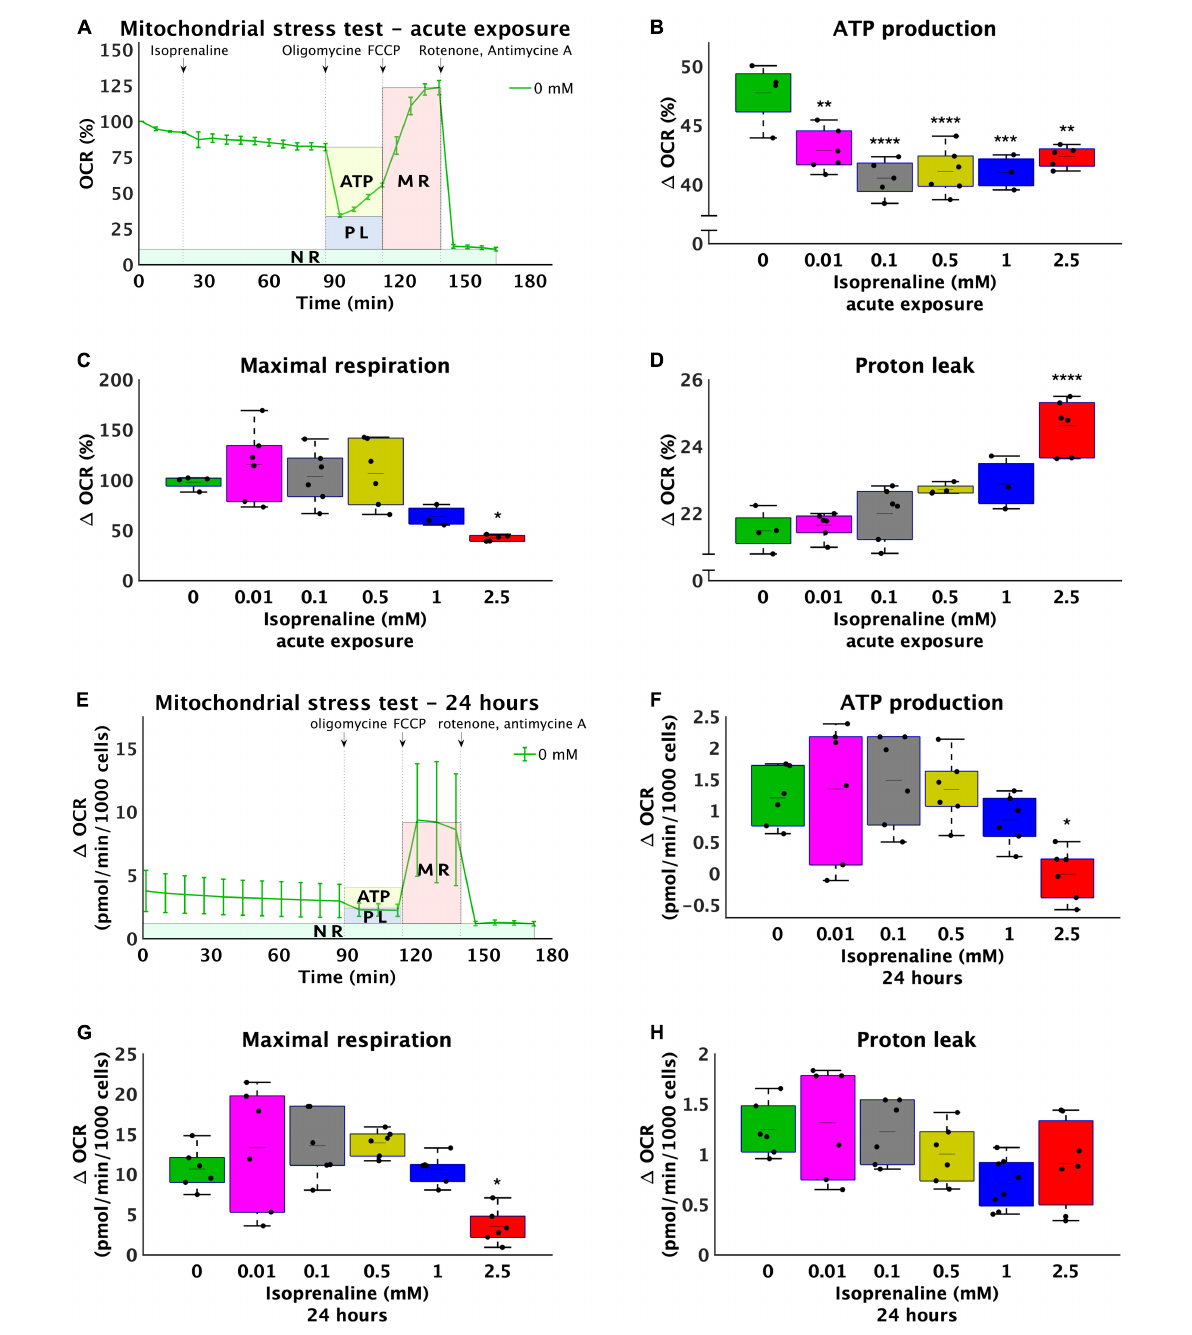
FIGURE1 Increasing doses of isoprenaline impair mitochondrial functions. (A) Representative graph of the oxygen consumption rate (OCR) of HL-1 cardiomyocytes exposed to different levels of isoprenaline showing the calculation of mitochondrial functions after acute ISO exposure. NR, non-mitochondrial respiration, ATP, ATP production, PL, proton leak, MR, maximal respiration, (B) Quantification of ATP production calculated from (A) , one-way ANOVA: p = 5.83 × 10 − 5 . (C) Quantification of maximal respiration from (A) , one-way ANOVA: p = 0.0009. (D) Quantification of proton leak from (A) , one-way ANOVA: p = 2.79 × 10 − 7 . (A–D) n = 3–6 biological replicates per group, one technical replicate, (E) Representative graph of the oxygen consumption rate (OCR) of HL-1 cardiomyocytes exposed to different levels of isoprenaline showing the calculation of mitochondrial functions after 24 h of exposure to ISO. (F) Quantification of ATP production from (E) , one-way ANOVA: p = 0.0041. (G) Quantification of maximal respiration from (E) , one-way ANOVA: p = 0.0006. (H) Quantification of proton leak calculated from (E) , one-way ANOVA: p = 0.028. (E–H) n = 6 biological replicates per group, one technical replicate. Statistical significance was assessed using one-way ANOVA followed by Tuckey multiple